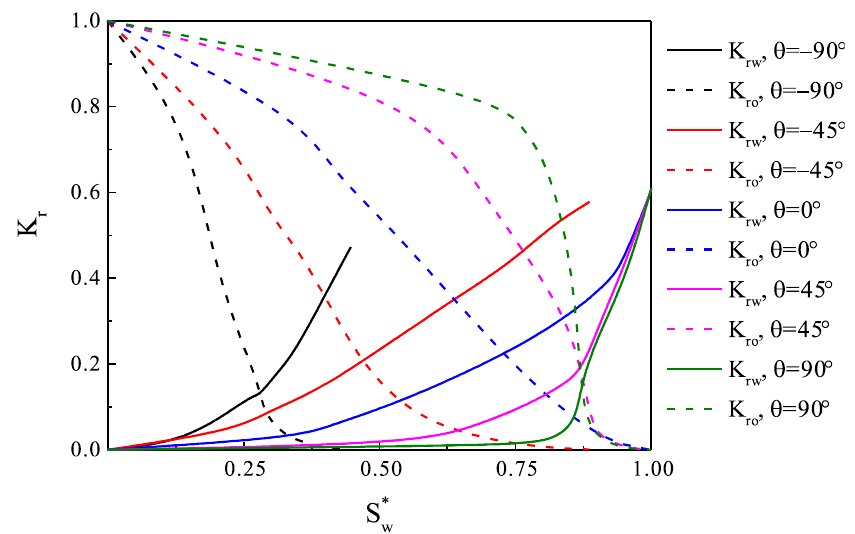
Figure 17. Upscaled relative permeability of the single-vug model for five different flow directions.